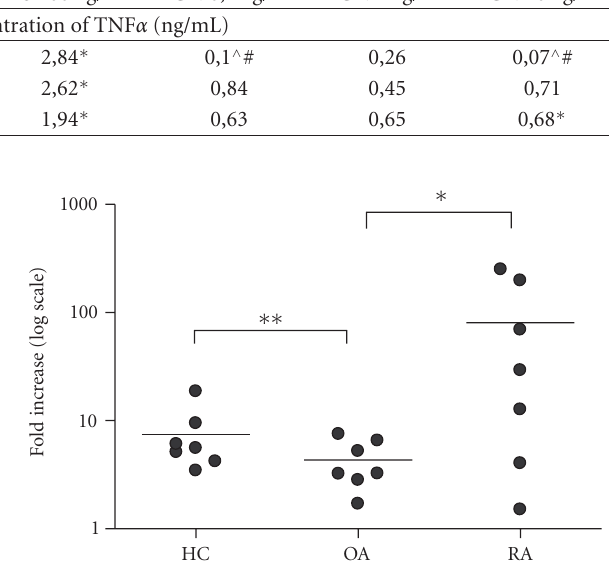
Figure 2: Individual changes in TNF α concentration in the supernatants of human leucocytes culture after stimulation with LPS 100ng/mL; log 10 scale; HC-healthy controls; OA-osteoarthritis; RA-rheumatoid arthritis; ∗ p = . 04; ∗∗ p = . 027.